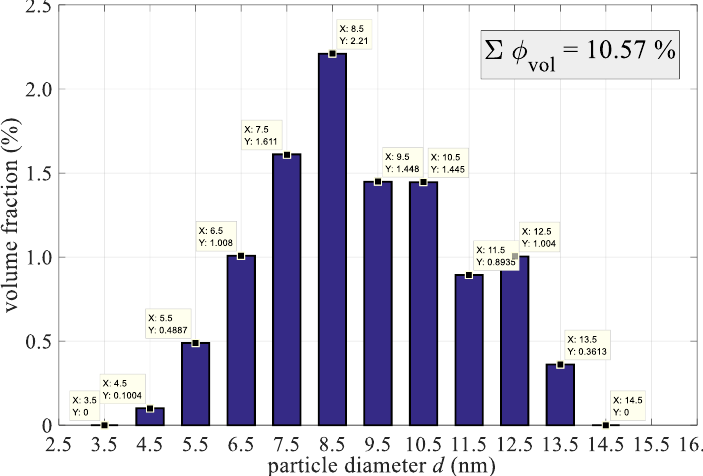
Figure 3. Volume percent of each size-group of particles in suspension.